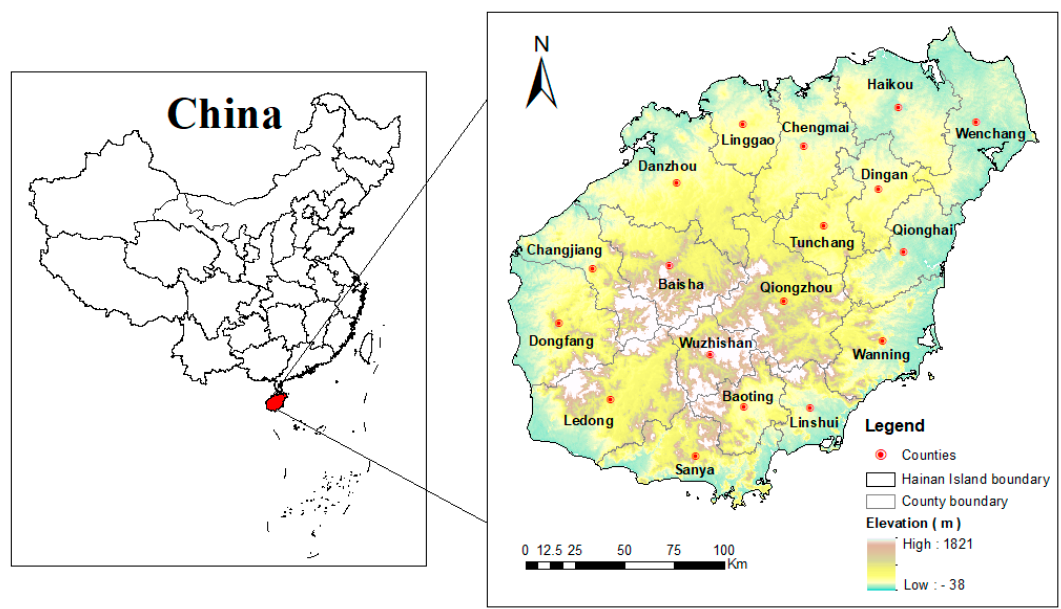
Figure 1. Map of Hainan Island together with the county boundary and relative elevation change.